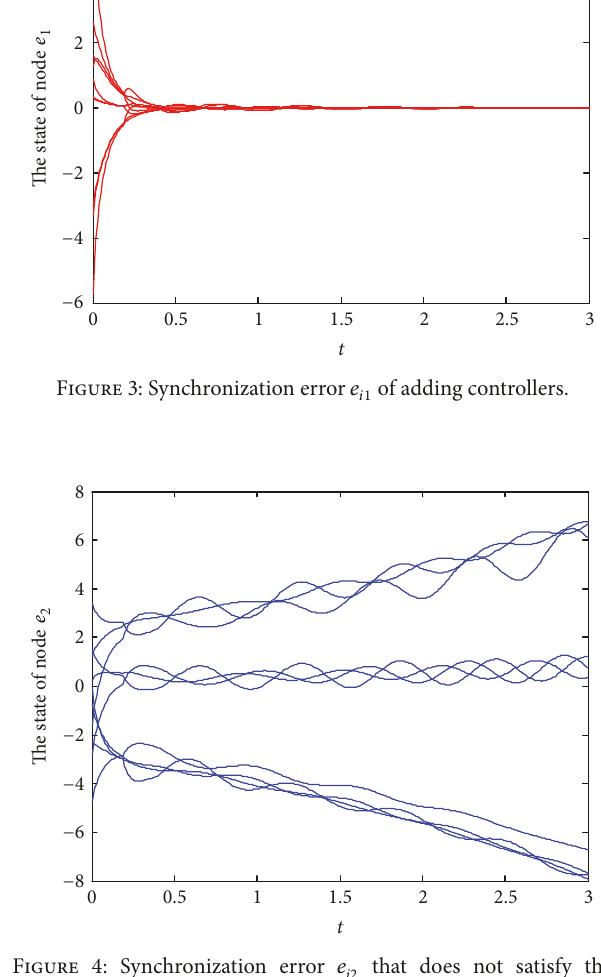
Figure 4: Synchronization error 𝑒 𝑖2 that does not satisfy the conditions.